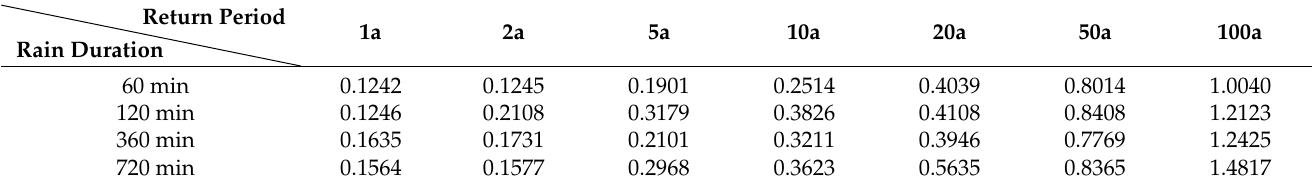
Table 5. Average submerged depth of all the rainstorm scenarios. Average submerged depth